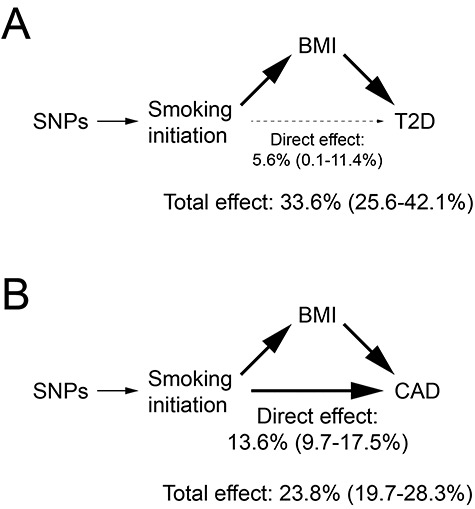
Models for how genetically determined smoking initiation risk impacts cardiovascular disease traits. (A) SNPs determine genetic risk of smoking initiation. By MR-Steiger estimates (33), smoking initiation directionally influences BMI. From mediation analysis (17), the total and direct effects of smoking initiation on type 2 diabetes risk (T2D) are shown, representing increased odds of T2D (with 95% confidence interval) per 2-fold increase in genetically determined smoking initiation risk. (B) Both smoking initiation and BMI have strong independent effects on CAD risk. Total and direct effects of smoking initiation on CAD are shown, representing increased odds of CAD (with 95% confidence interval) per 2-fold increase in genetically determined smoking initiation risk.